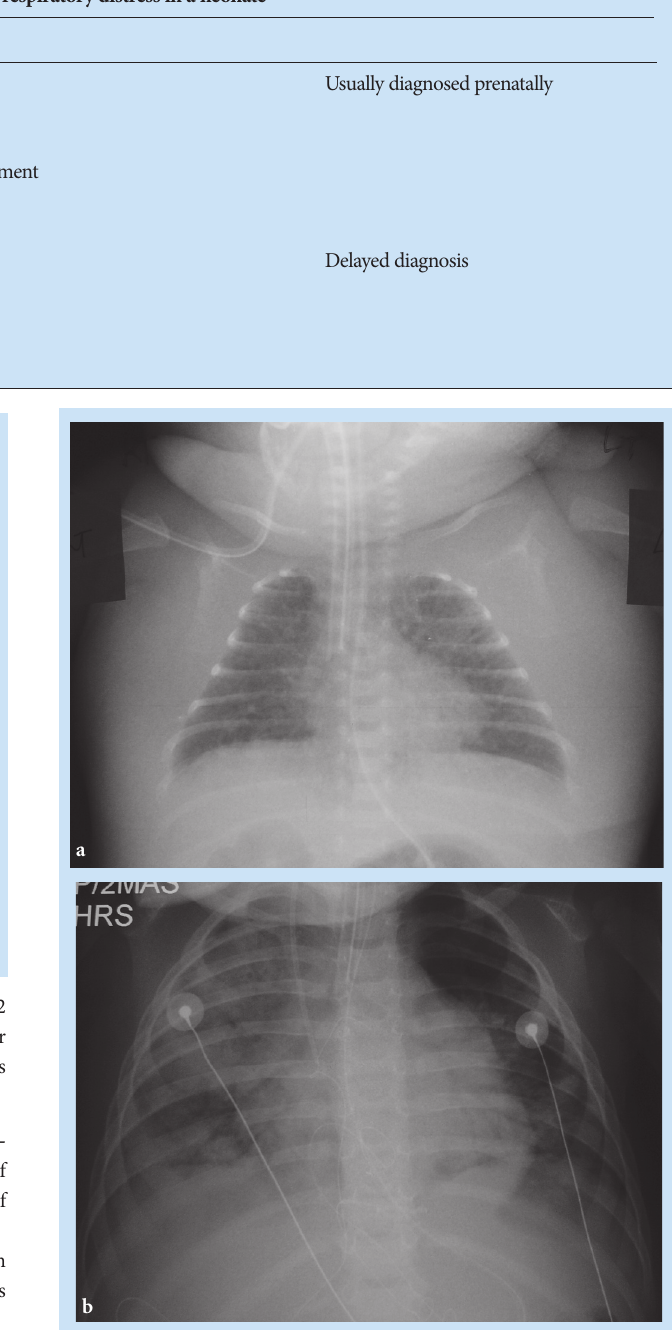
Table III. Other causes of respiratory distress in a neonate 1,4